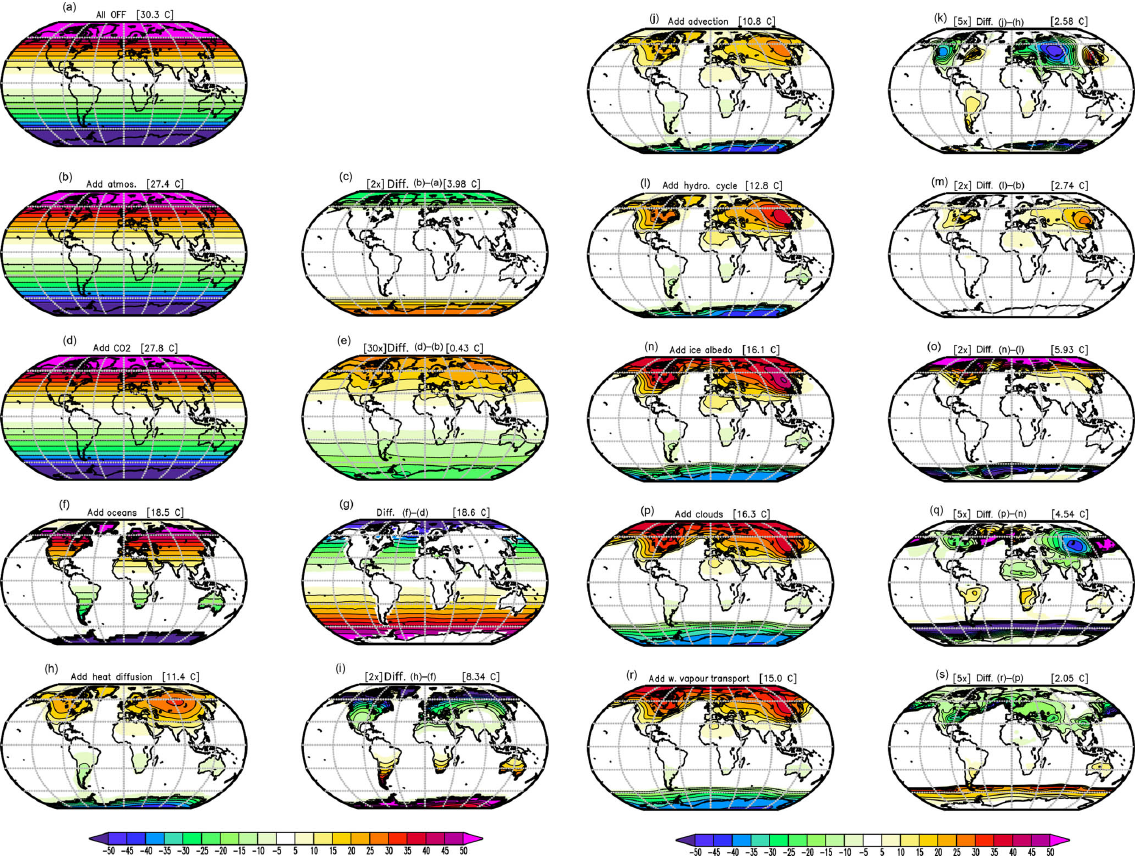
Figure 9. As in Fig. 8, but conceptual build-up of the seasonal cycle. The seasonal cycle is defined by the difference between the months (JAS – JFM) divided by two. Global mean absolute values are shown in the heading. In some panels the values are scaled for better comparison: (c) , (i) , (m) , and (o) by a factor of 2; (k) , (q) , and (s) by a factor of 5; and (e) by a factor of